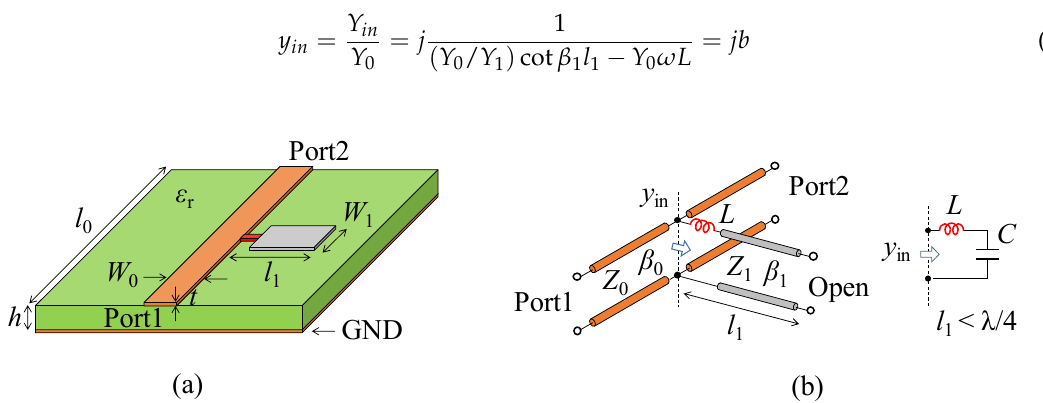
Figure 3. Circuit model of an MSL open-circuited stub with inductance inserted at the attachment point to the main transmission line. ( a ) Schematic view of MSL open circuited stub with a reactive element; ( b ) equivalent circuit of MSL open-circuited stub with an inductance L .